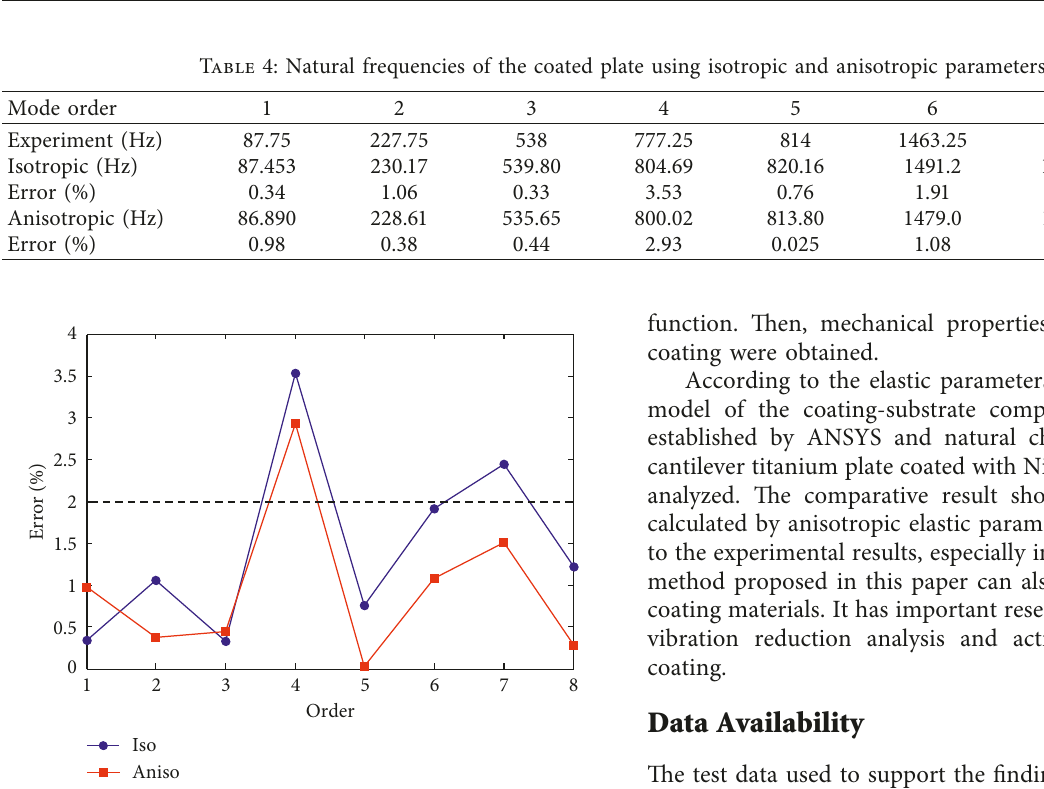
Figure 14: The errors of the natural frequencies calculated by isotropic and anisotropic